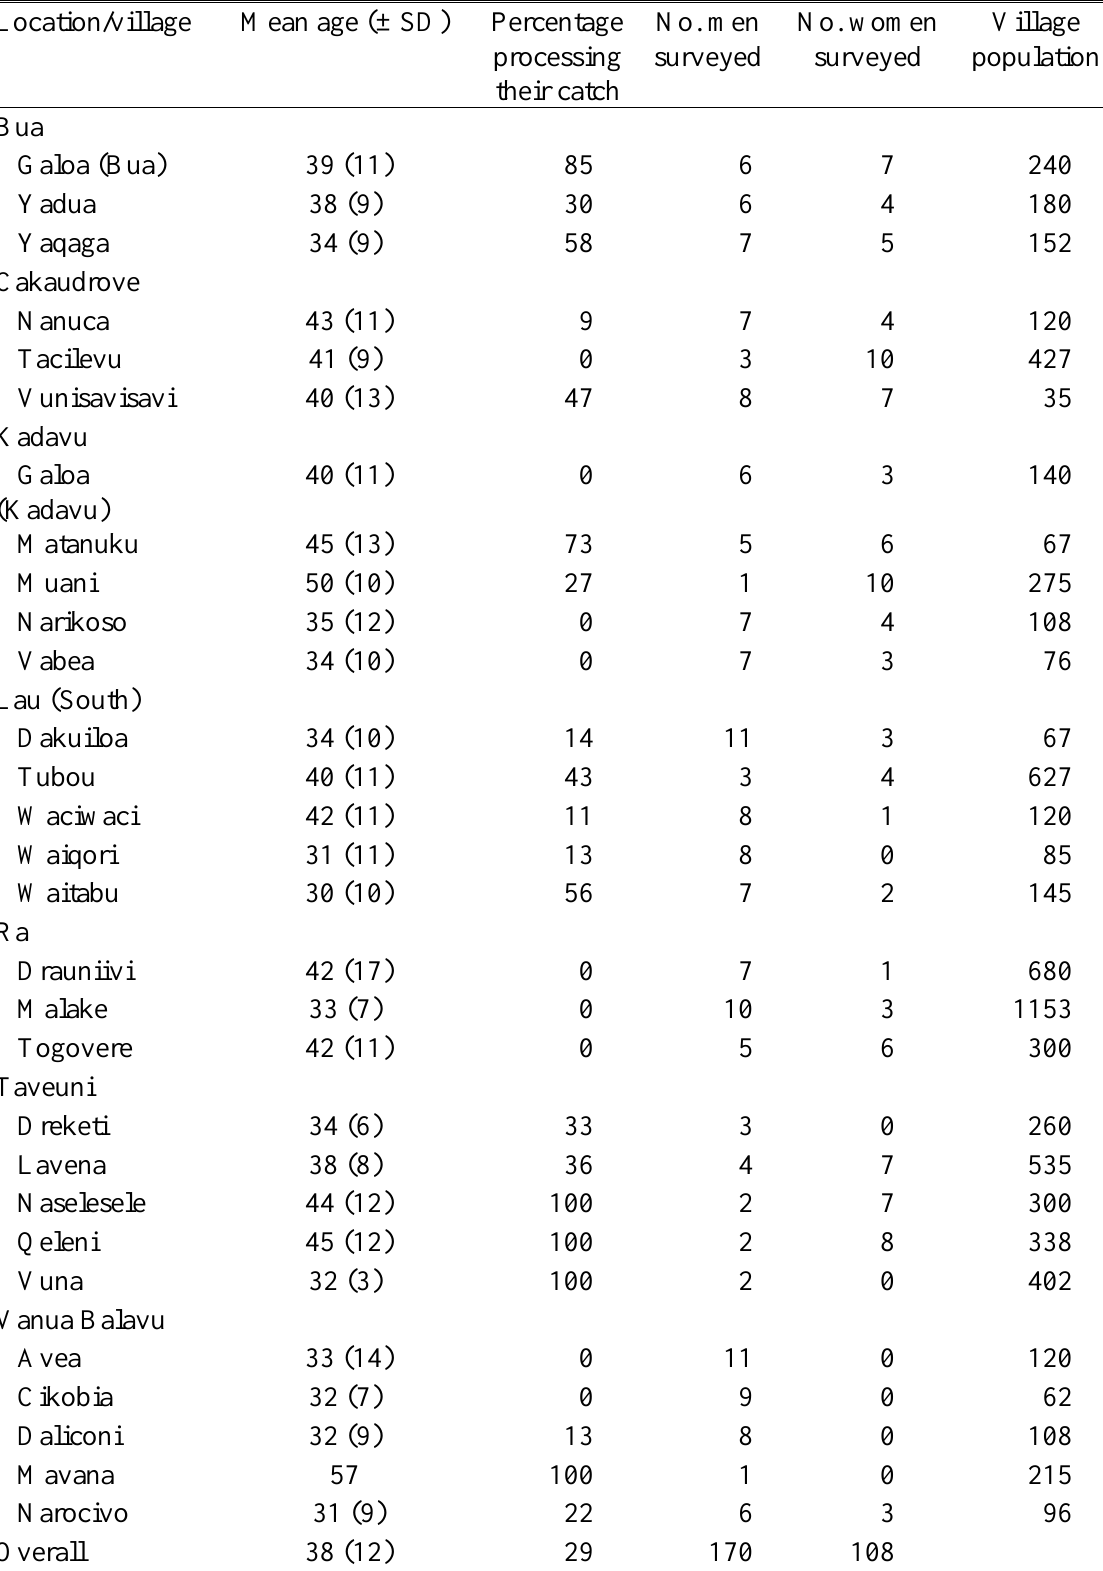
Table A1.1 Summary statistics of respondents of fisher